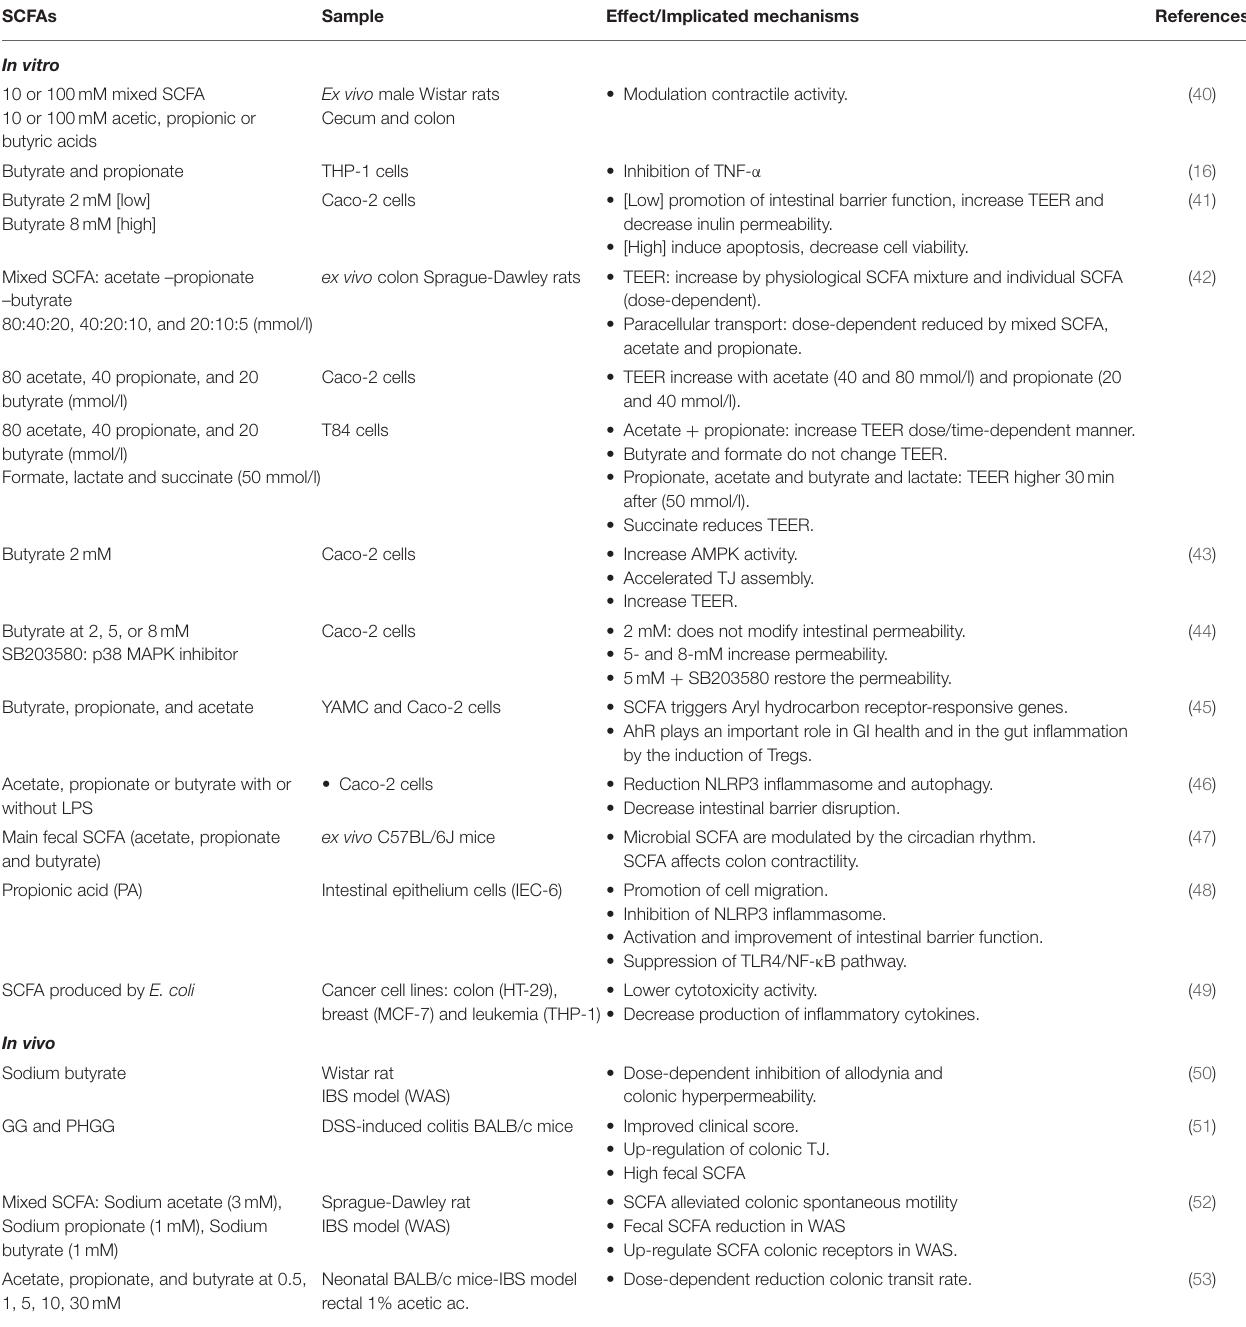
TABLE 2 | Short-chain fatty acids role in the recovery of impaired barrier function.